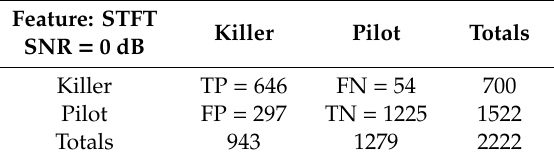
Table 9. Classification results: STFT, SNR = 0 dB.